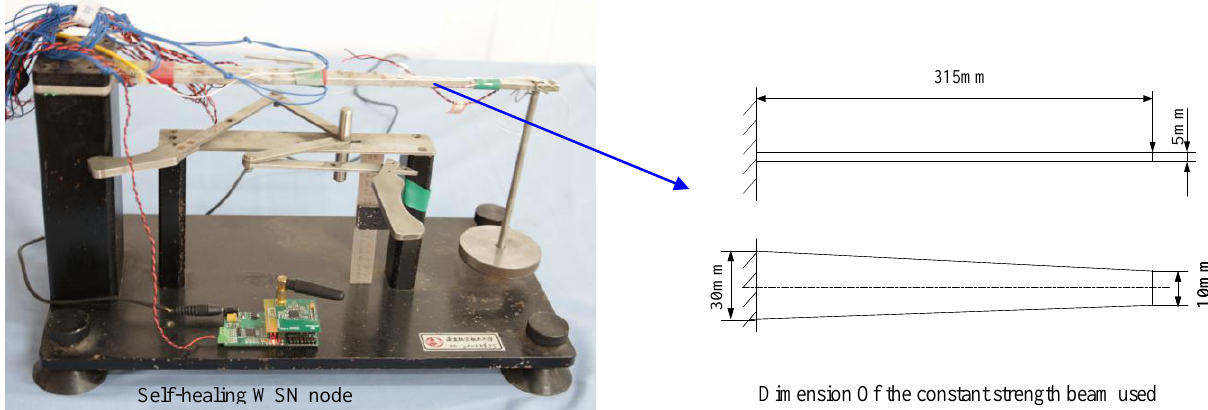
Figure 14. Constant strength beam-based experimental